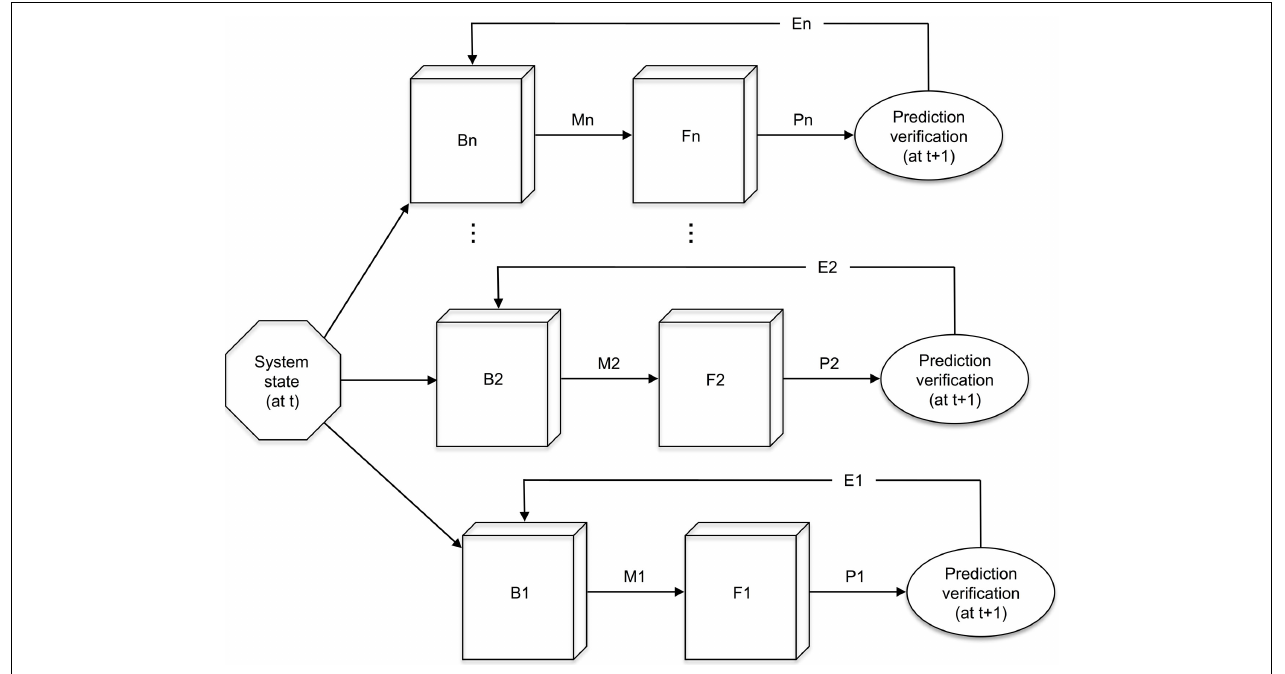
FIGURE 3 | The HAMMER architecture, showing multiple inverse models (B1 to Bn) taking as input the current system state, which includes a desired goal, suggesting motor commands (M1 to Mn), with which the corresponding forward models (F1 to Fn) form predictions of the